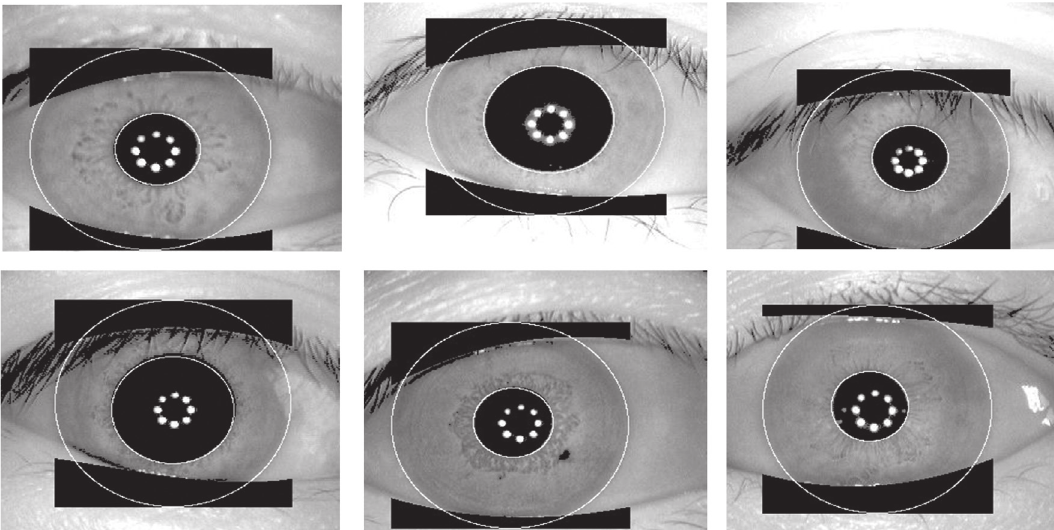
Figure 18. Successful Localization of the Upper and Lower Eyelids by the Proposed Method on Various Challenging Iris Images.